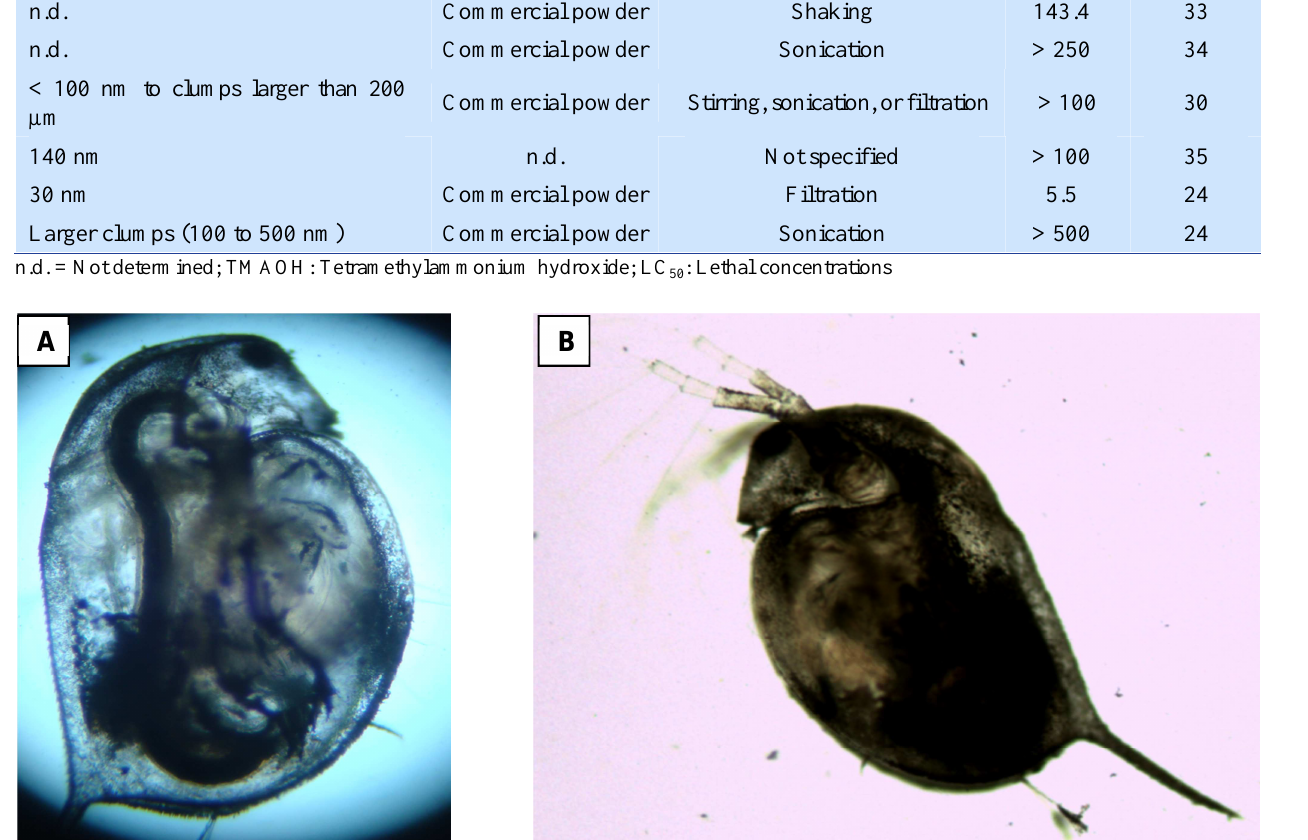
Figure 6. The uptake and adsorption of titanium dioxide (TiO exposure to aqueous suspension of Titanium dioxide nanoparticles (nTiO are observable on the whole body surface, in the brood chamber, and carapace. In addition, the dark appearance of the gut tract shows that nTiO